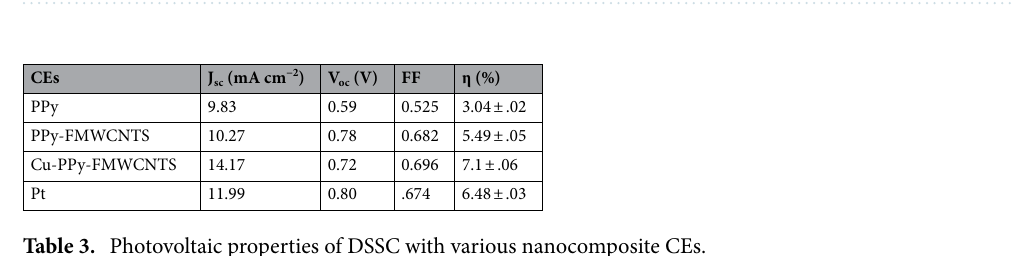
Figure 6. Photocurrent density–voltage curves of DSSCs with, PPy, PPy-FMWCNTS and Cu-PPy-FMWCNTS nanocomposites as CEs.